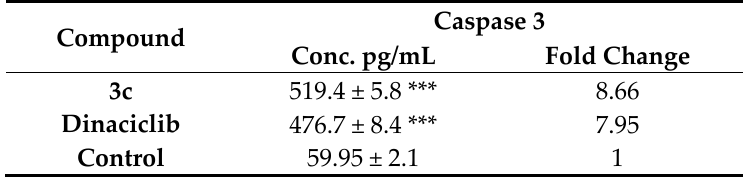
Table 5. Caspase-3 conc. (pg/mL) ± SEM and fold change levels for 3c and Dinaciclib on the SK- MEL-5 cell